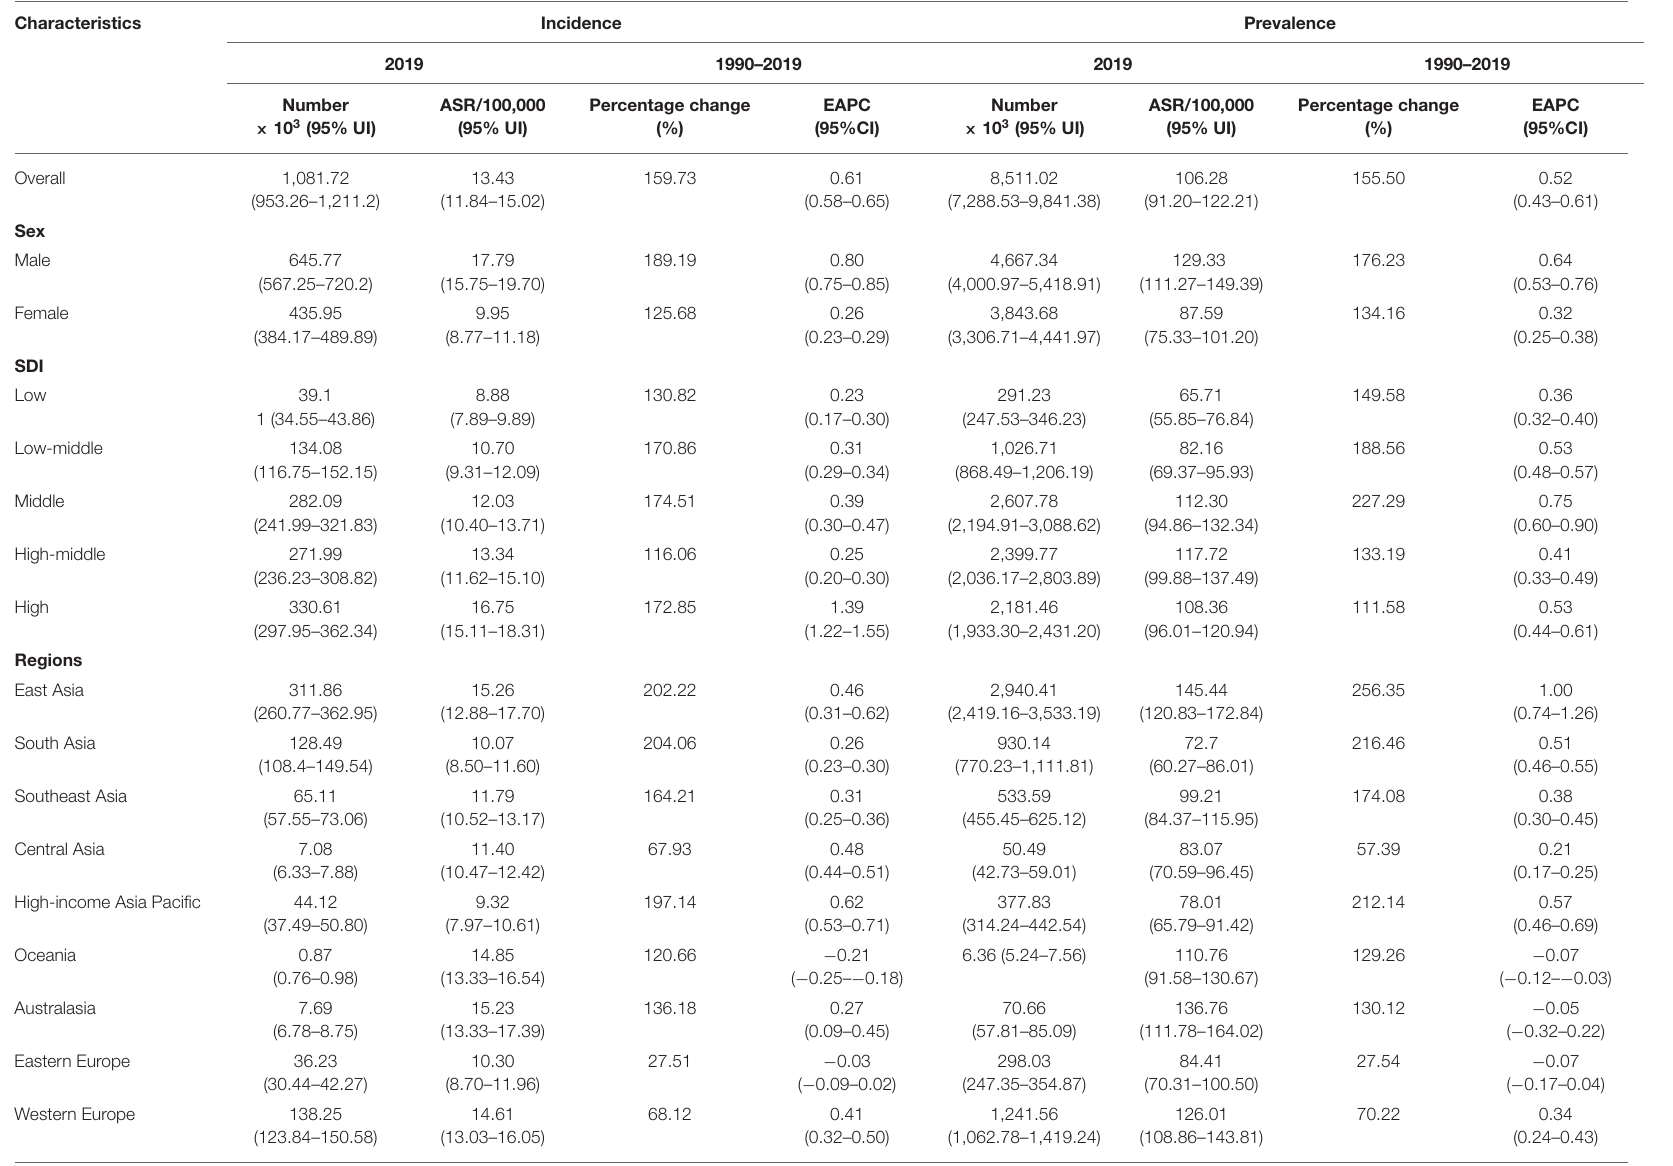
TABLE 1 | The changes in incidence and prevalence of Parkinson’s disease worldwide, and in sexes, SDI areas, and regions, 1990–2019.